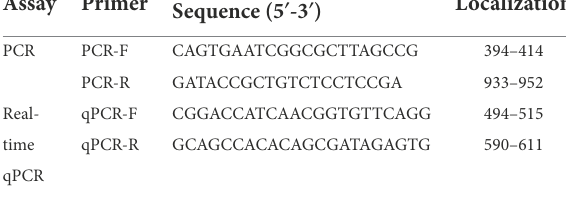
TABLE 1 Real-time qPCR and PCR assays of primers sequences for CIAV. Assay Primer Sequence (5 ′ -3 ′ )